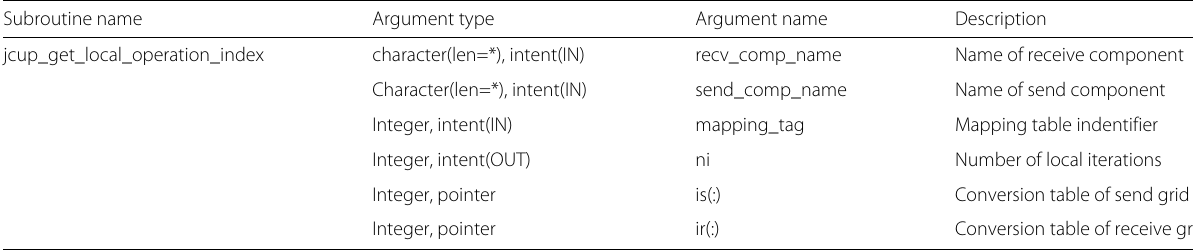
Table 3 Interface of jcup_get_local_operation_index